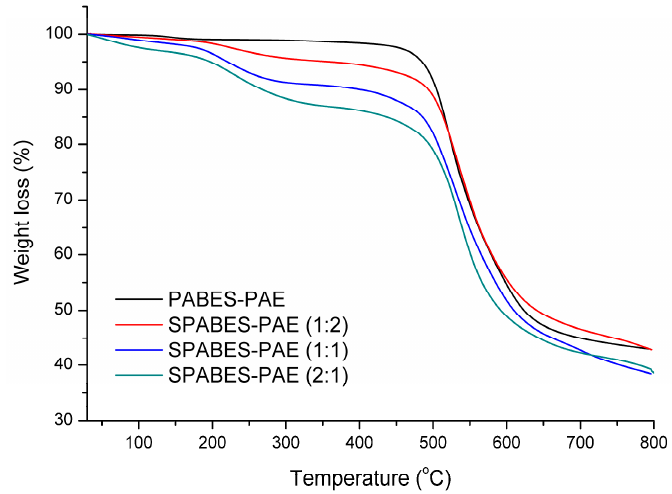
Figure 3. Thermogravimetric curves of the block copolymers measured at 10 °C·min − 1 under nitrogen flow.